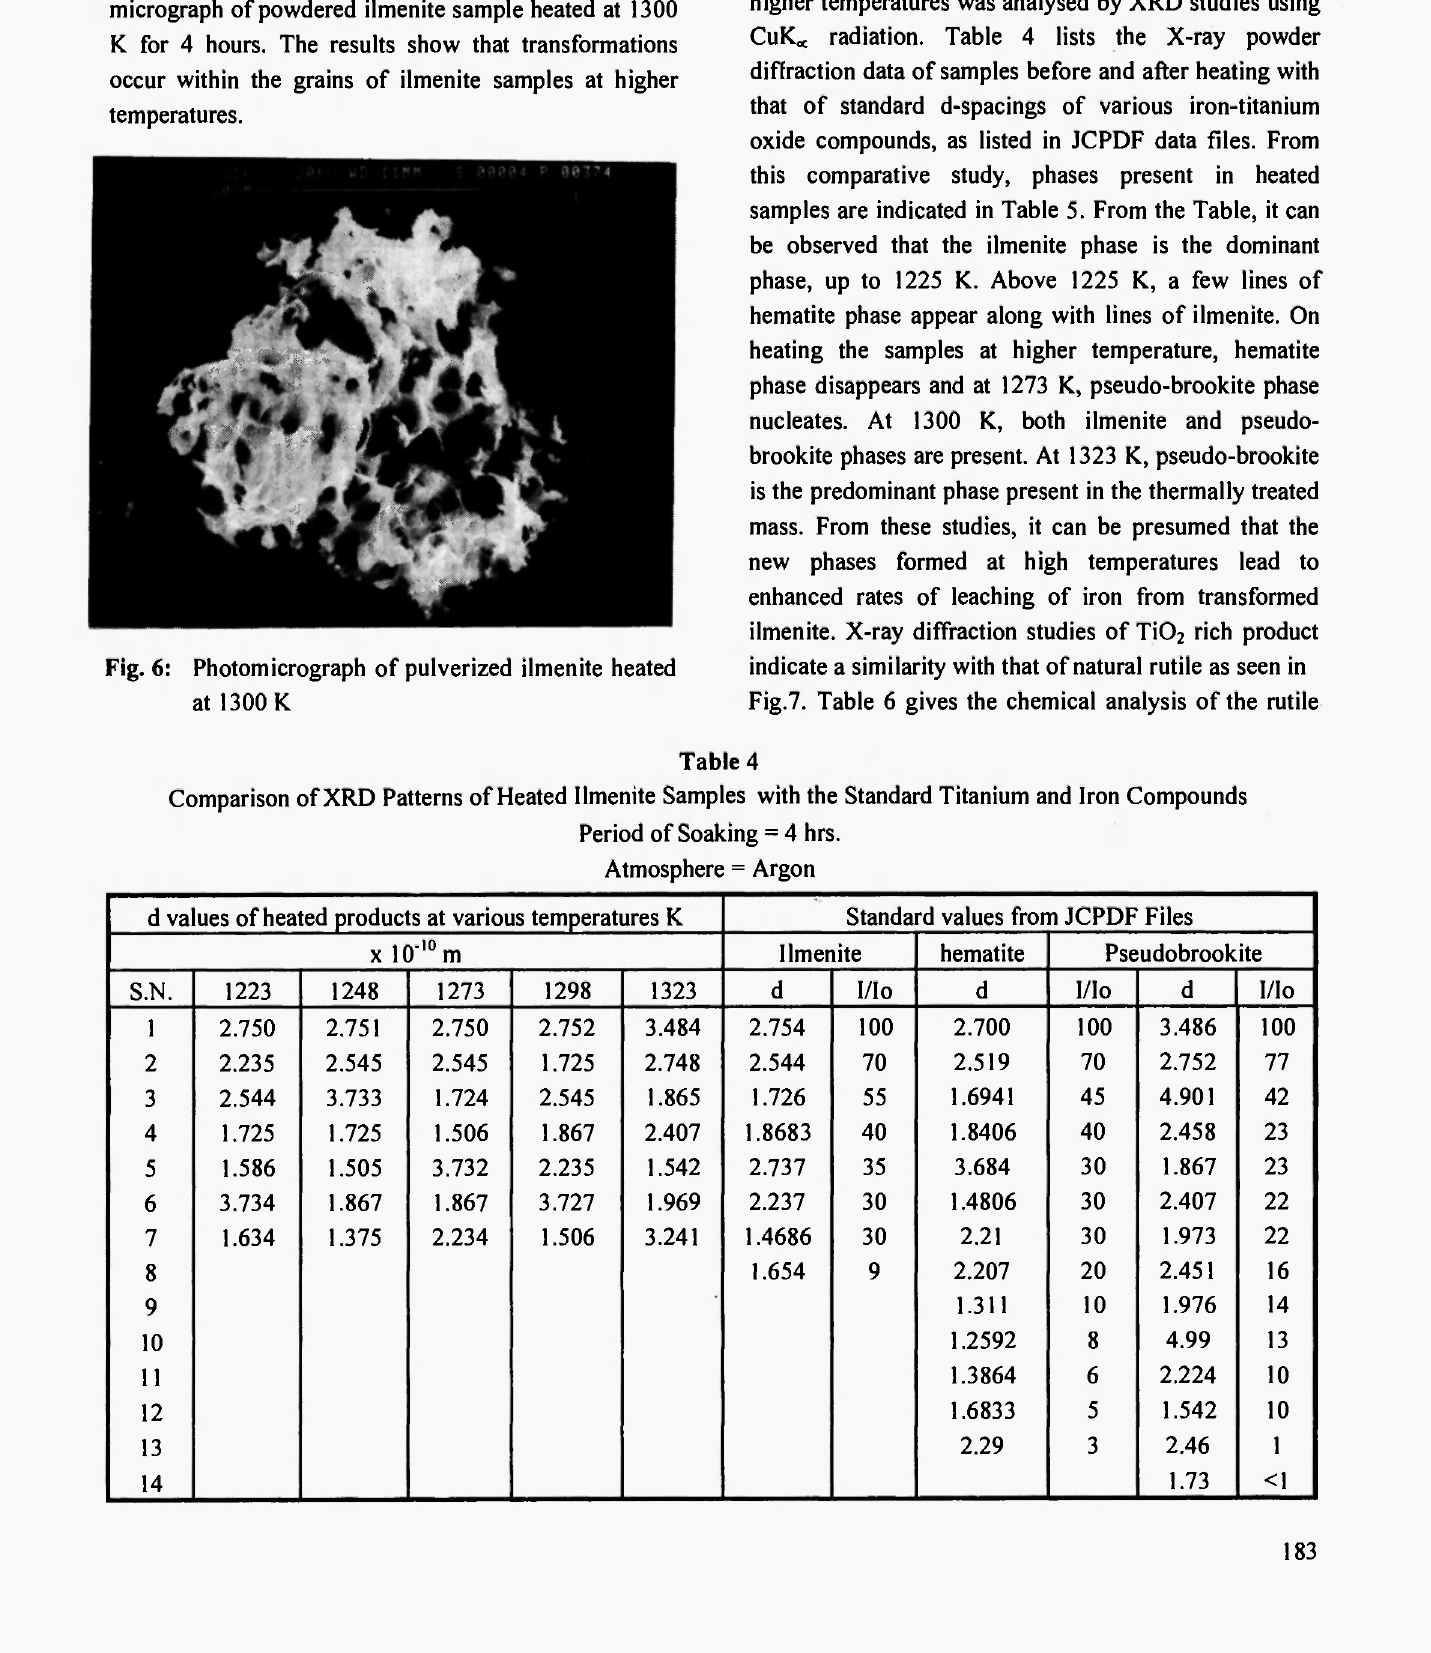
Fig. 6: Photomicrograph of pulverized ilmenite heated